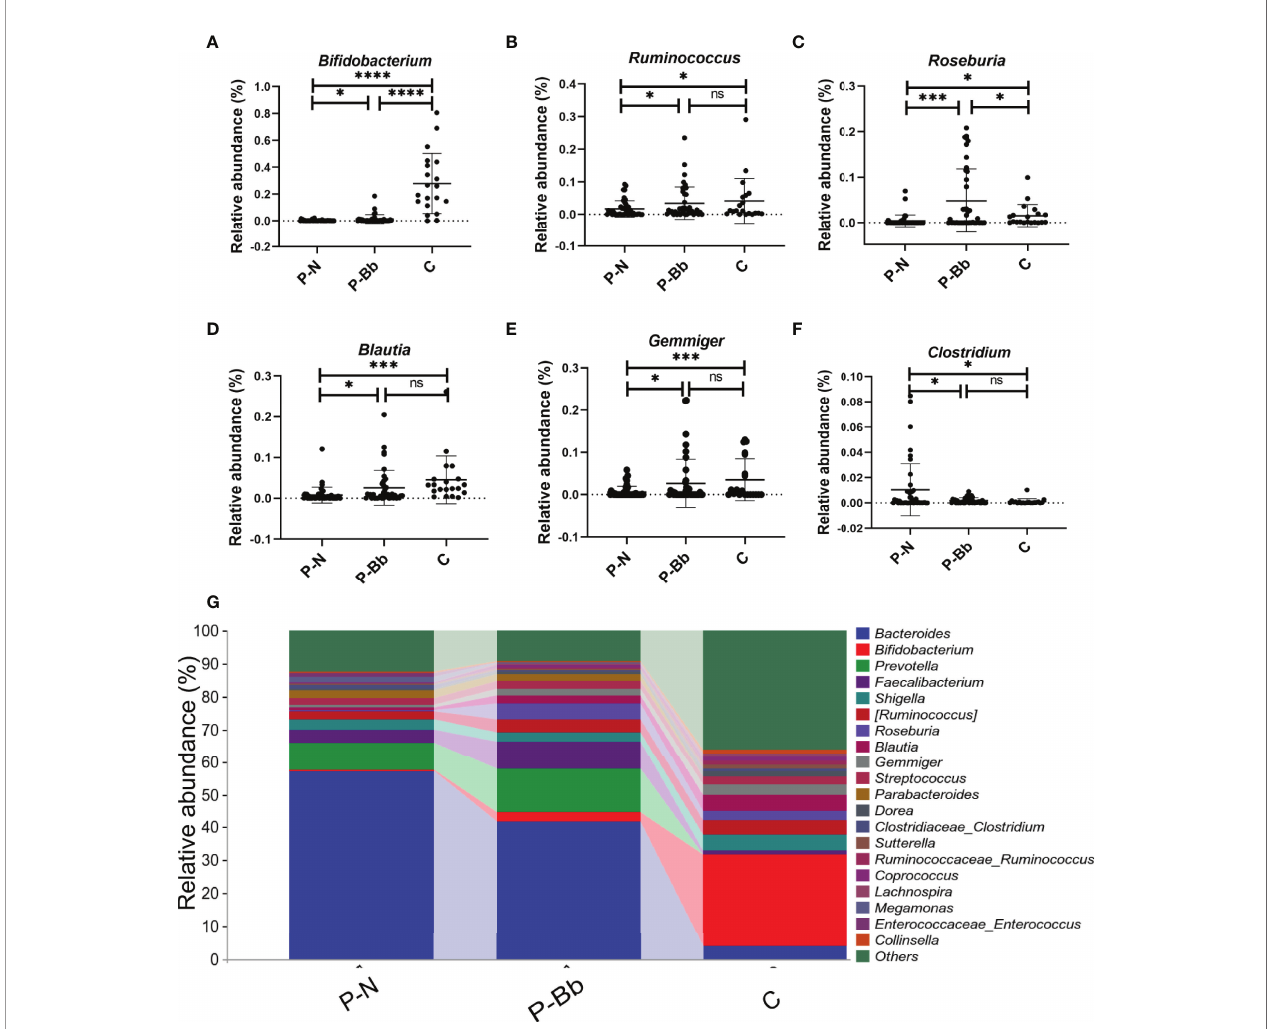
FIGURE 3 | MH-02 can help restore the majority of the postoperative intestinal microbiota towards healthy people. Values are presented as means ± SD (41 P-Bb, 44 P-N,20 C). (A – F) The relative abundance of Bi fi dobacterium , Ruminococcus , Roseburia , Blautia , Gemmiger and Clostridium . (G) The species composition analysis of P-Bb, P-N and C group. *p < 0.05, ***p < 0.001, ****p < 0.0001, ns, no signi fi